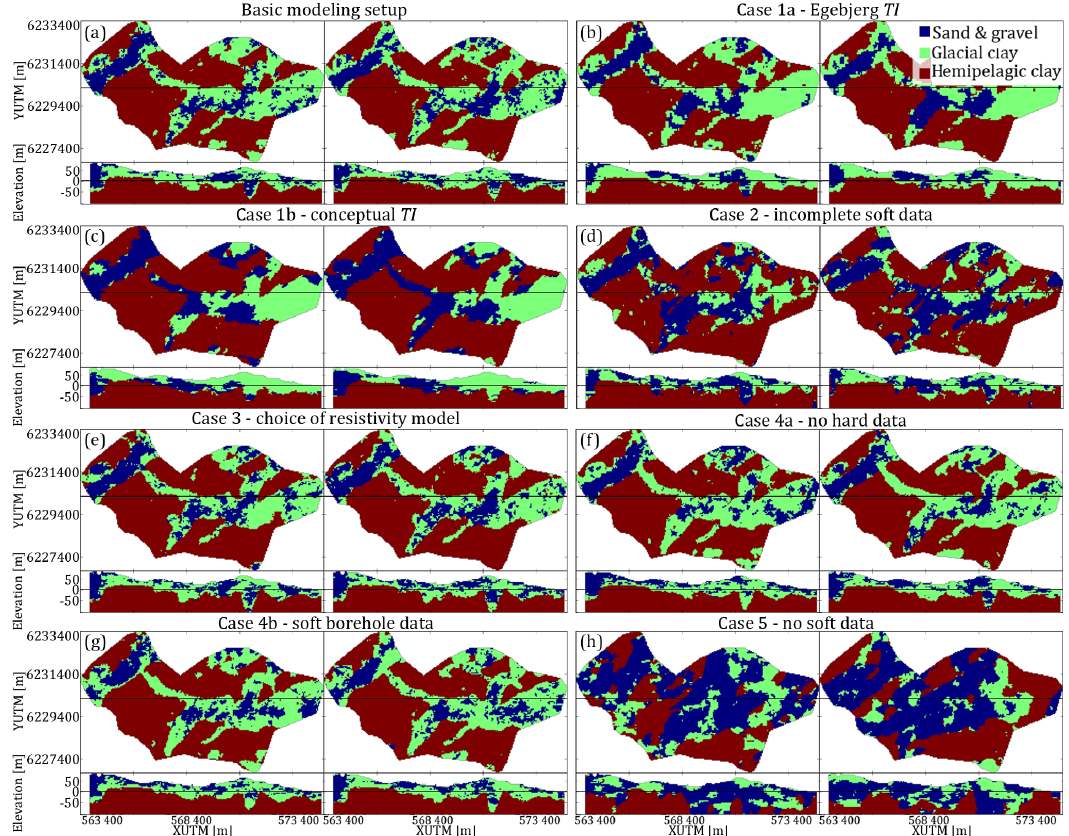
Figure 9. Each case is displayed by two realizations: realization no. 1 of 50 and realization no. 30 of 50. Each realization is portrayed as a horizontal slice at 20mb.s.l. and a vertical cross section intersecting at YUTM 6230100m. (a) shows the realization results for the basic modeling setup, (b) shows the realization results for case 1a, (c) shows the realization results for case 1b, (d) shows the results for case 2, (e) shows the results for case 3, (f) shows the results for case 4a, (g) shows the results for case 4b, and (h) shows the results for case 5. For more details on individual cases the reader is referred to Table